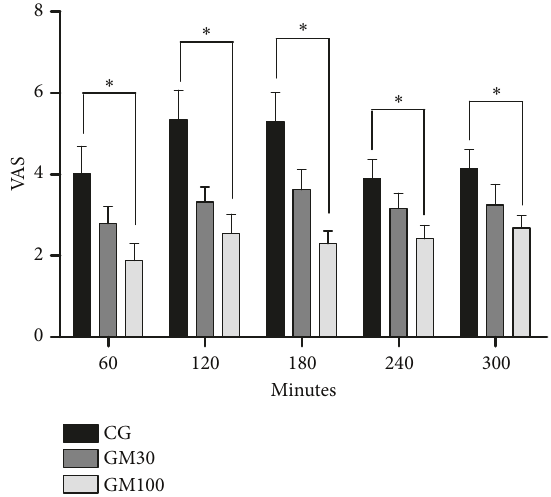
Figure 2: Mean ± standard error of the mean scores for the visual analog pain scale in cats following ovariohysterectomy. ∗ Pain score different between the control group (CG) and those receiving maro- pitant 100 𝜇 g/kg/h (GM100) throughout postoperative